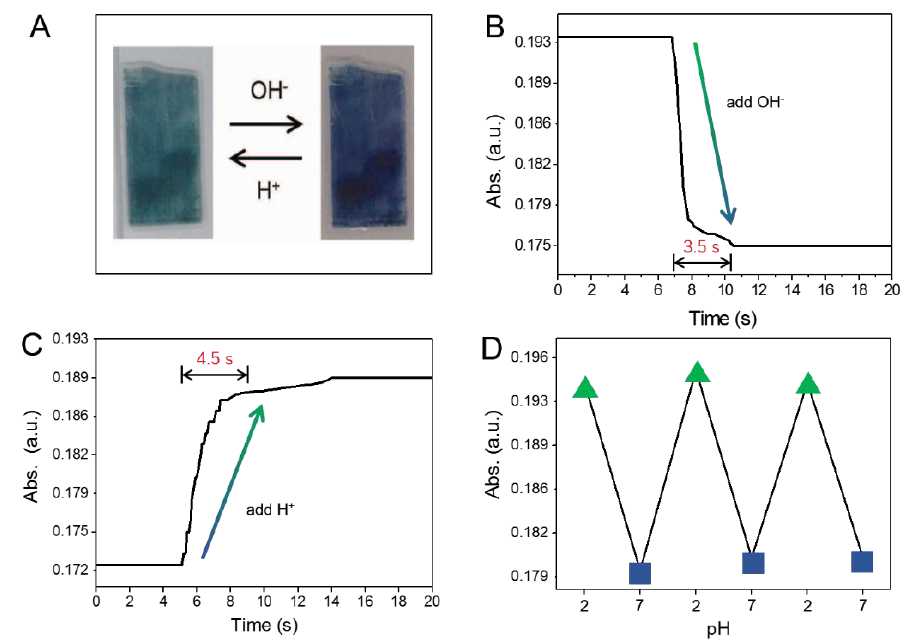
Figure 6. ( A ) Optical images of PANI-GNPs-glass, showing the color changes between acid (low pH) and alkaline (high pH) medium; ( B ) The response curve from acid medium (pH = 2) to alkaline medium (pH = 7) at 785 nm; ( C ) The response curve from alkaline medium (pH = 7) to acid medium (pH = 2) at 785 nm; ( D ) The absorbance changes of PANI-GNPs-glass biosensor at 785 nm upon switching between pH = 2 and 7 media (three cycles).